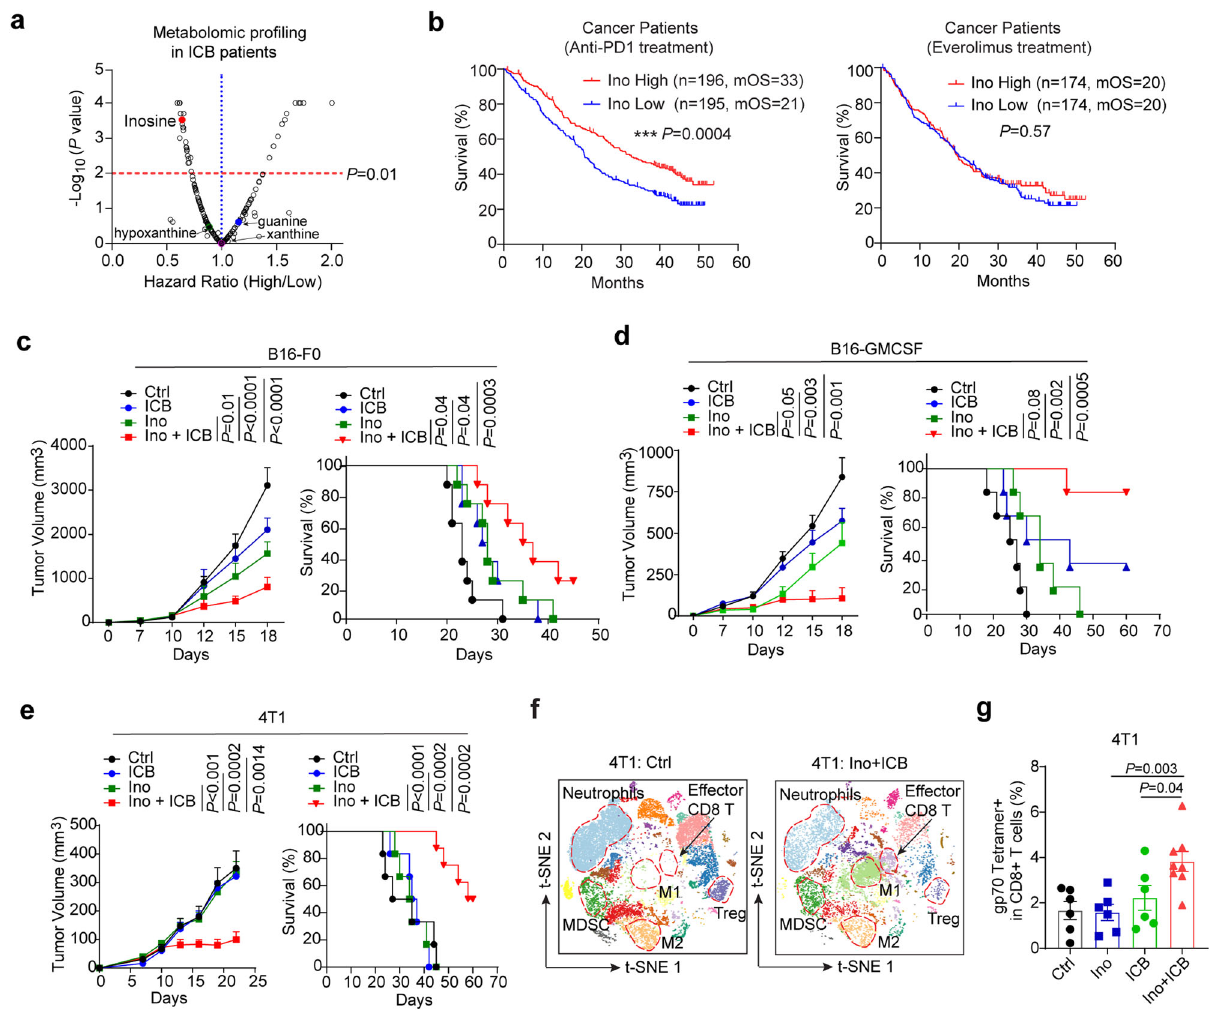
Fig. 1 | Inosine overcomes resistance to immunotherapy by in fl aming tumour immune microenvironment. a Volcano plot showing the hazard ratios (HR) of high/low levels of serum metabolites ( n =202, represented as points, high and low are strati fi ed by the median of each metabolite) in CheckMate 025 renal cell car- cinoma (RCC) patients with nivolumab (anti-PD1 Ab) treatment ( n =392). Overall survivalisusedasaCoxproportionalhazardsmodel.Acutoffat P =0.01isshownas a horizontal line and HR (high/low)=1 is shown as a vertical line (HR: high/low <1 indicates that a high level of a metabolite is a bene fi t for ICB patients). b Kaplan – Meier plot of overall survival in RCC patients with nivolumab (anti-PD1 Ab)(High, n =196,meanOS=33;Low, n =195,meanOS=21)oreverolimus(mTOR inhibitor)(High, n =174,meanOS=20;Low, n =174,meanOS=20)groupedbythe